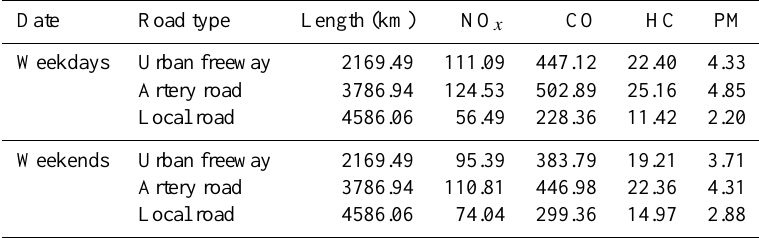
Table 2. Daily vehicle emission on different road types of Beijing (unit: Mgday − 1 )